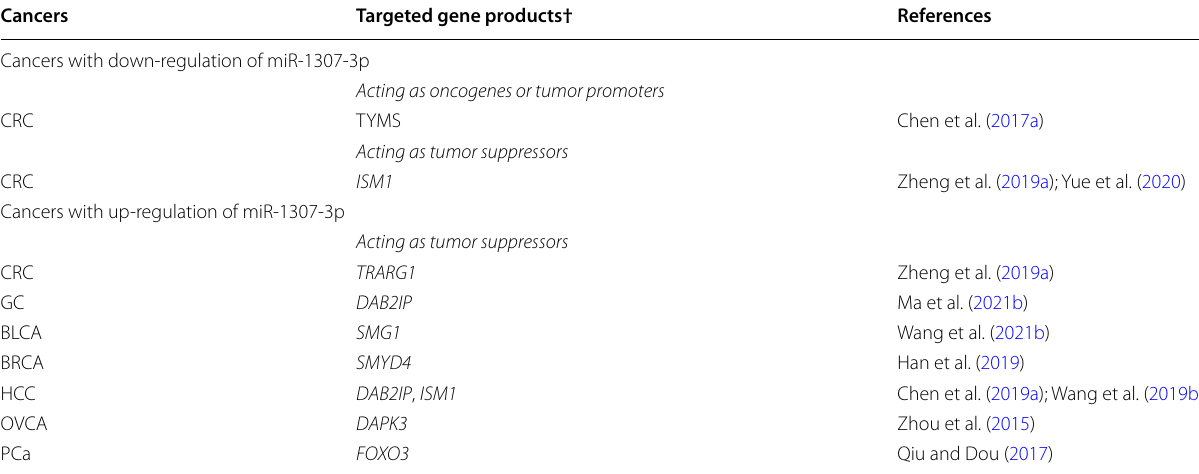
Table 18 lncRNA MALAT1 sponging miRNAs targeting TYMS lncRNA Confirmed or putative binding sites for